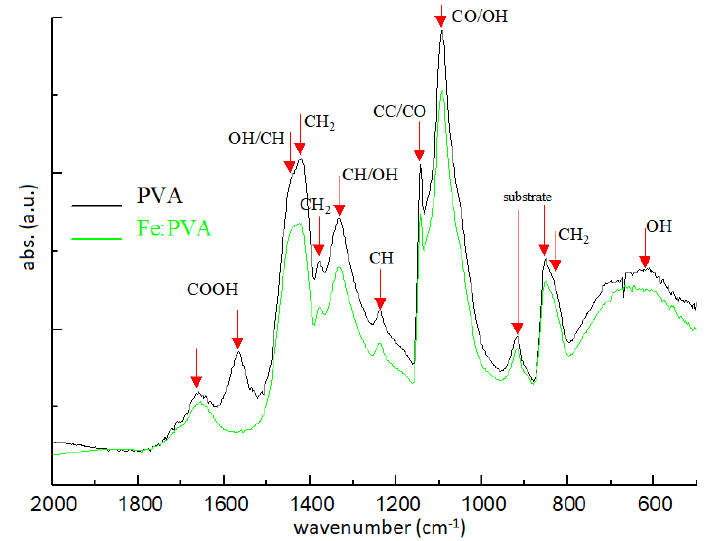
Figure 3. IR absorption spectra (FTIR at 4 cm − 1 resolution) for PVA (MW 14,000-completely hydrolyzed) and Fe:PVA (5 wt% FeCl 3 ).